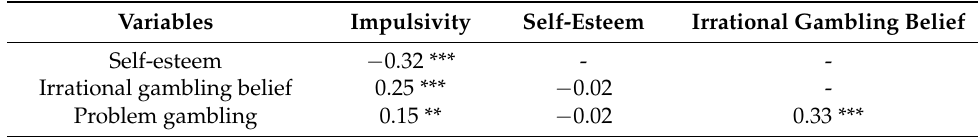
Table 3. Correlations among the main